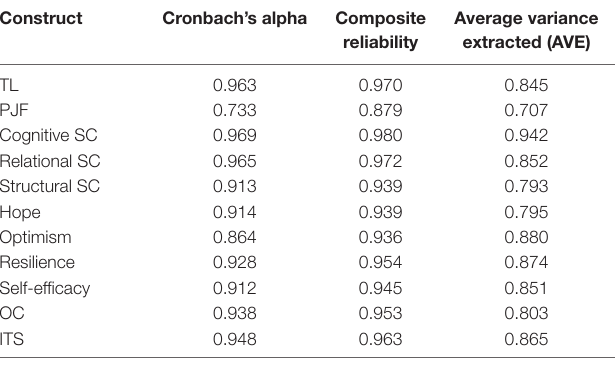
TABLE 1 | Convergent validity of